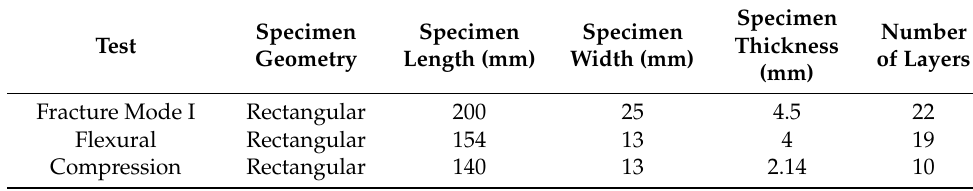
Table 2. Specimen description for each test